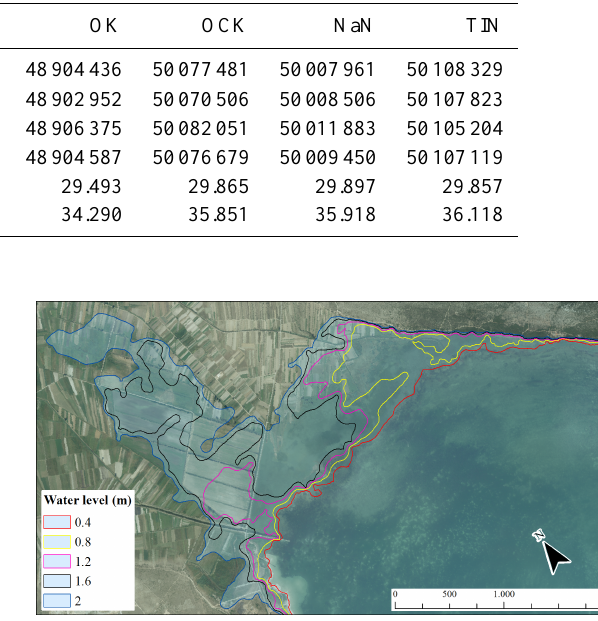
Table 5. Volume, surface and perimeter of Lake Vrana at 0.4m water level in reference to the Prosika gauge. Water level (0.4m)